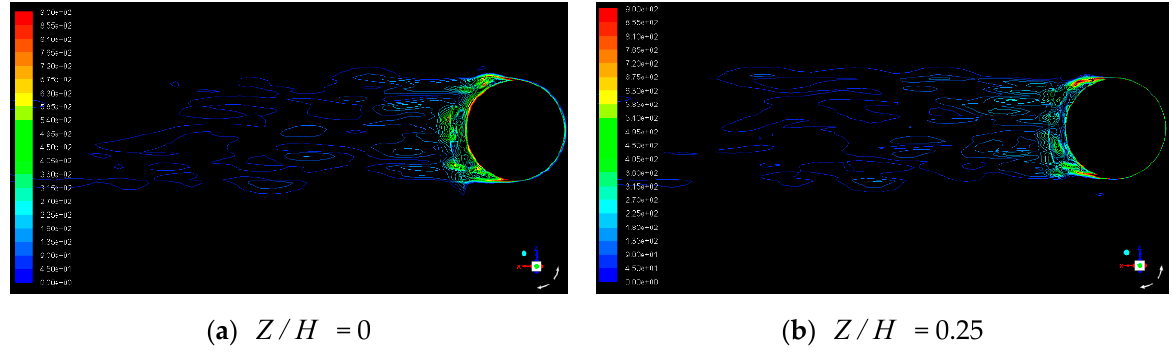
Figure 12. Instantaneous streamlines and contours of velocity in the horizontal plane at H / D = 5: ( a ) Z / H = 0; ( b ) Z / H = 0.25; ( c ) Z / H = 0.5 and ( d ) Z / H = 0.75.